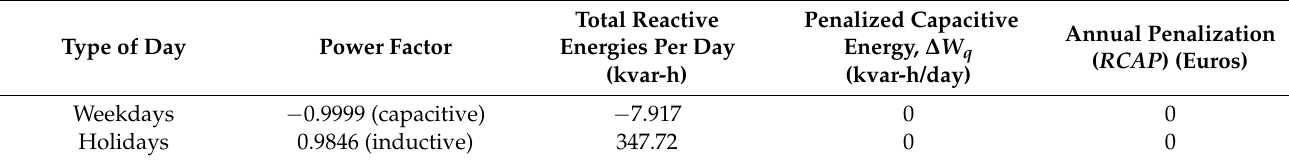
Table 8. Daily power factor and reactive energies and annual penalizations resulting from applying the first optimization procedure on the capacitor banks ( Q c 1 and Q c 2 ).